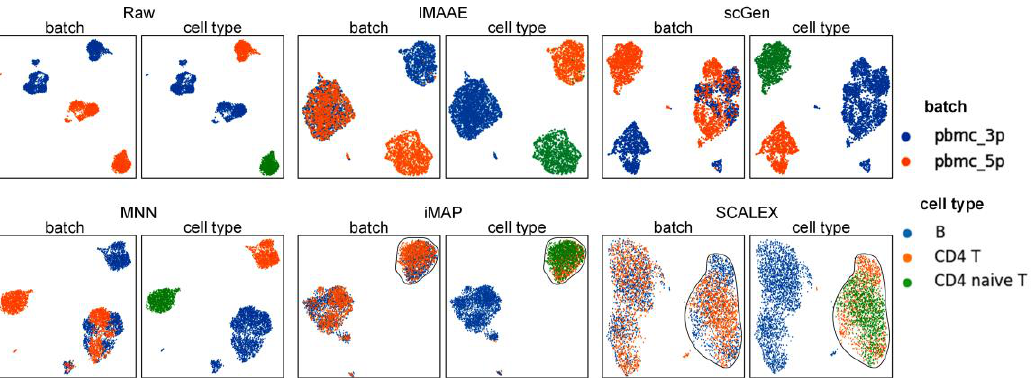
Figure 7. Qualitative evaluation of each batch correction method using UMAP visualization on PBMC-subset1 dataset. Each method contains two UMAP plots. On the left, coloring by batch type, and on the right, coloring by cell type.